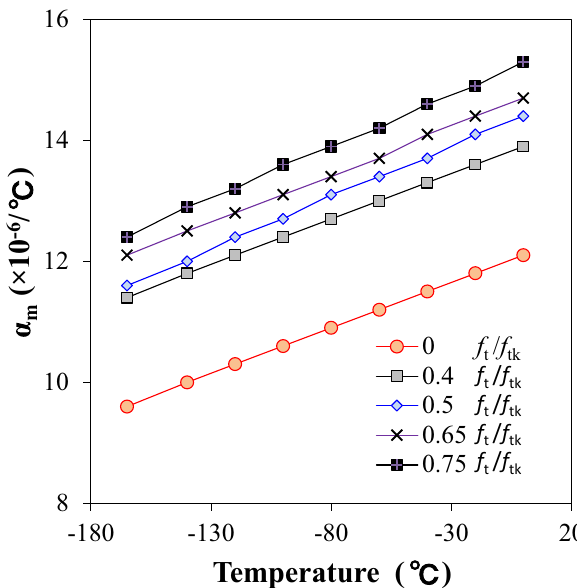
Fig. 6 Scatters of average linear expansion coefficient ver- sus temperature